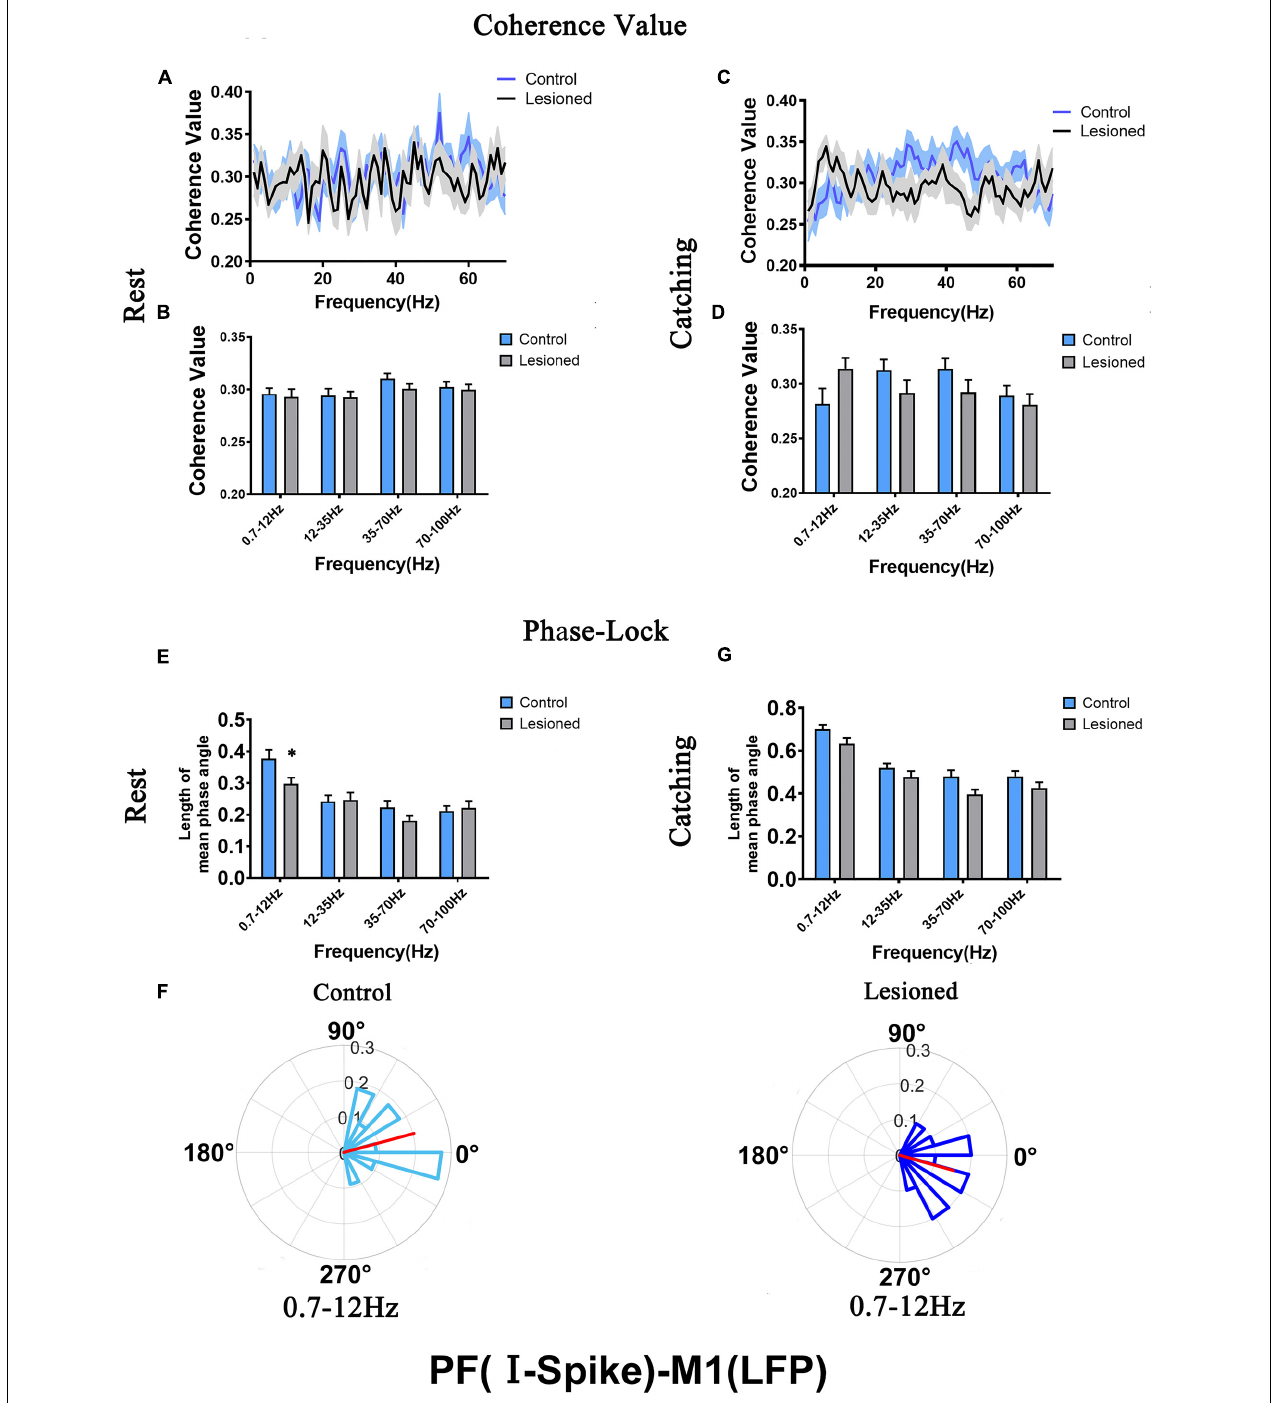
FIGURE 7 | Coherence values and phase-lock of PF-I with respect to M1-LFPs in the control rats and the DA lesioned rats. Coherence values between PF-I ( n = 21 neurons from 14 lesioned rats, and n = 28 neurons from 13 control rats) and M1-LFPs have no alterations during (A,B) rest and (C,D) catching movement states. During the resting epoch, phase-locking levels represented by the length of mean phase angle were significantly lower only in the range of 0.7–12 Hz in the lesioned rats compared to the control rats. Red lines radiating from the center indicated the measure of the strength of concentration of the distribution of the mean phase angle of all recording PF-I. Thus, PF-I neurons in the lesioned rats (dark blue) were less phase-locked to M1-LFP activities at 0.7–12 Hz than those neurons in the control rats (light blue) (E,F) . During catching movements, PF-I neurons in the lesioned rats did not significantly change in mean vector length compared to that of neurons in the control rats (G) . Data are expressed as the mean ± SEMs ( ∗ p < 0.05).